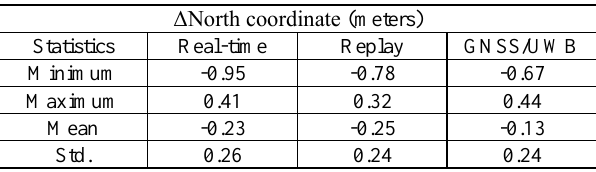
Table 6. Statistical value describing positioning errors in North direction.